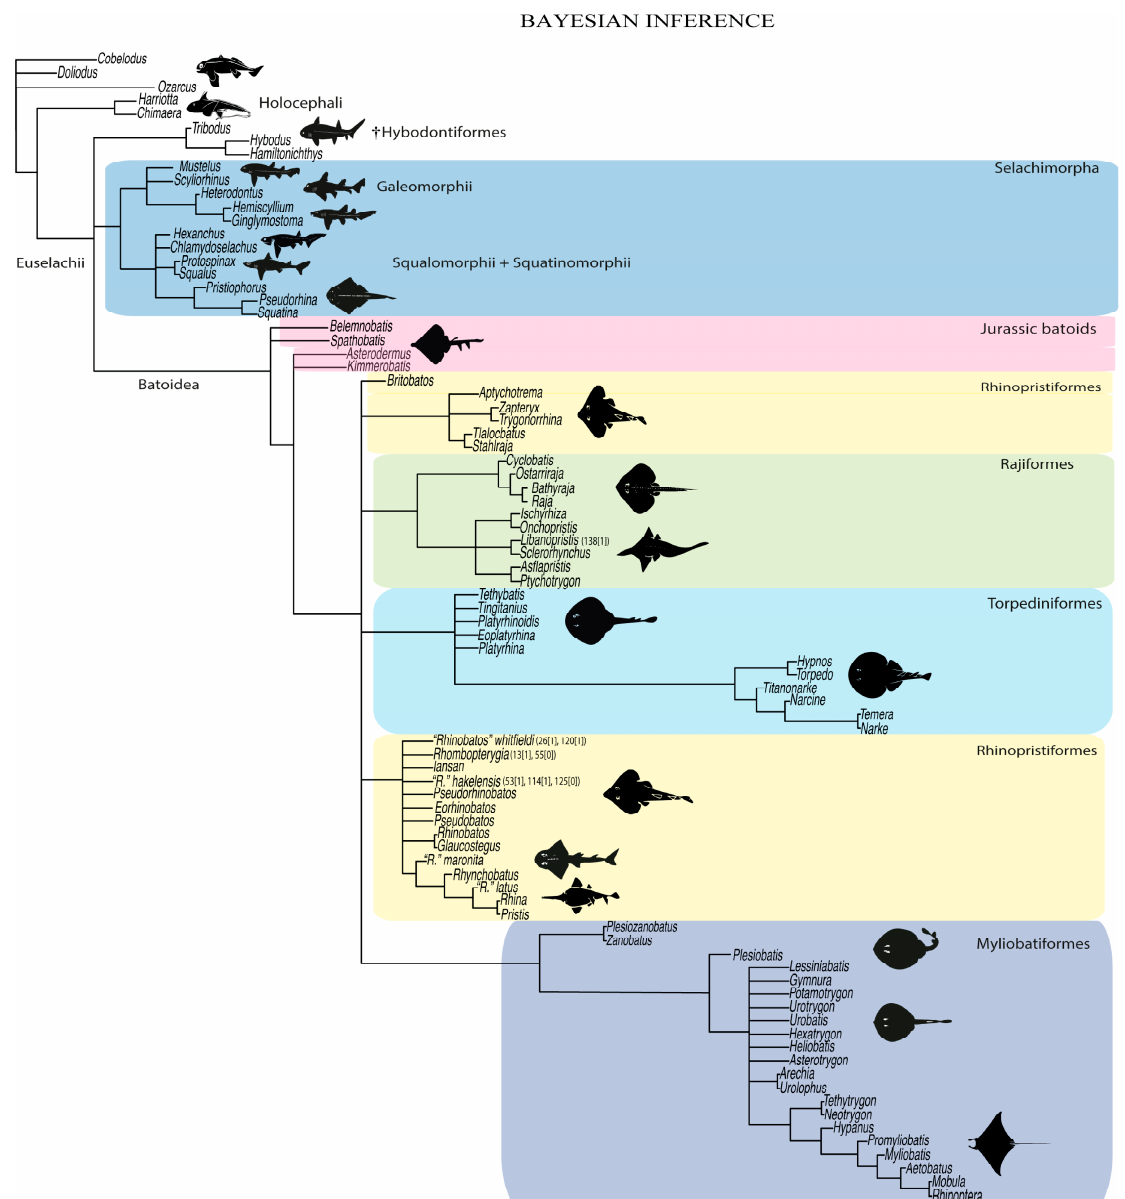
Figure 51. Posterior probability tree estimated from the Bayesian inference analysis in MrBayes. Main groups recovered in the analysis are marked with different